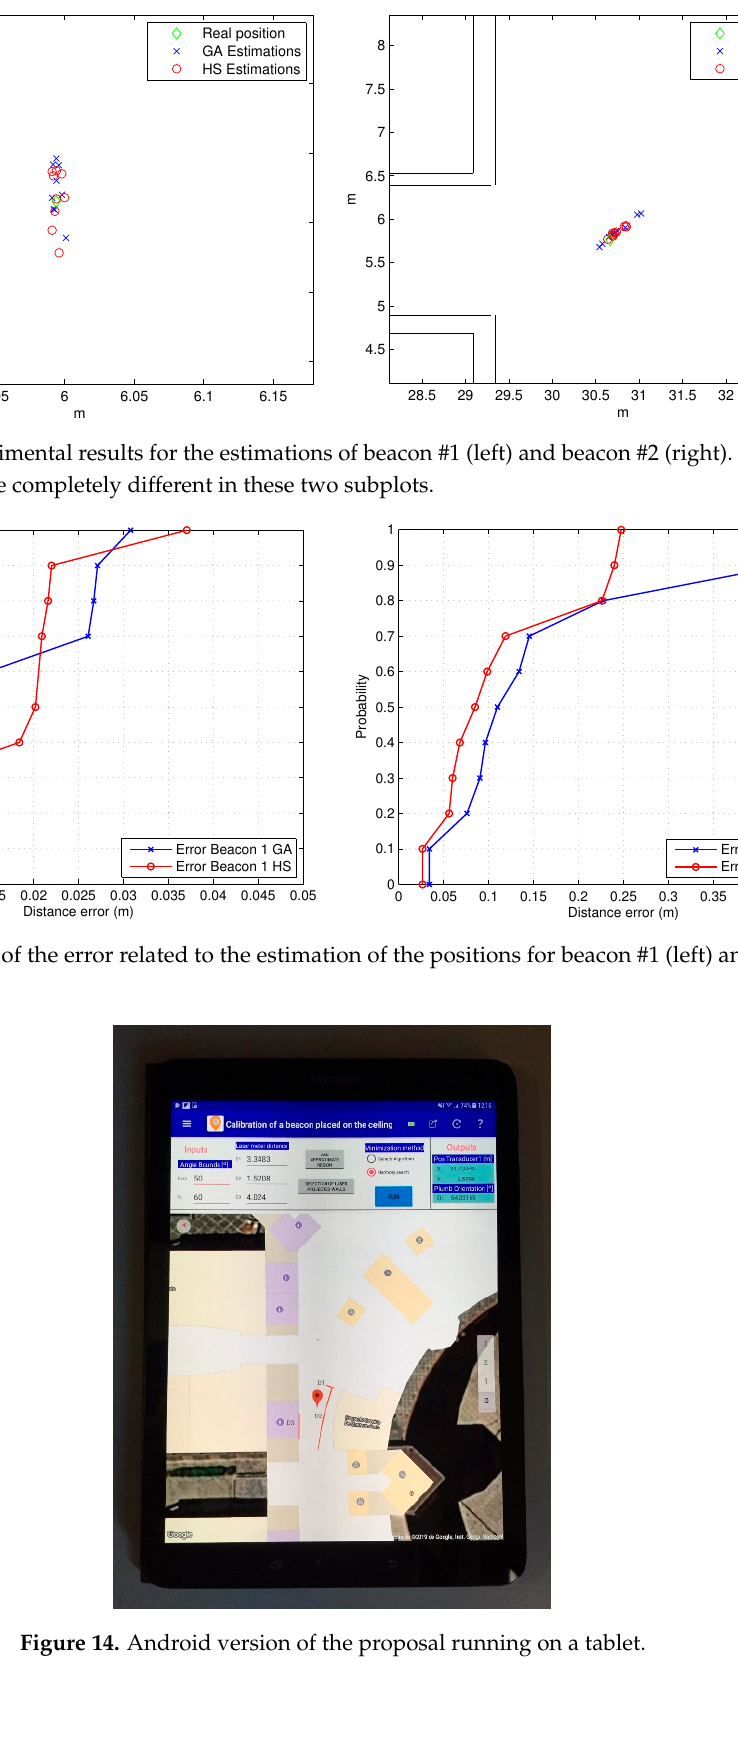
Figure 14. Android version of the proposal running on a tablet.